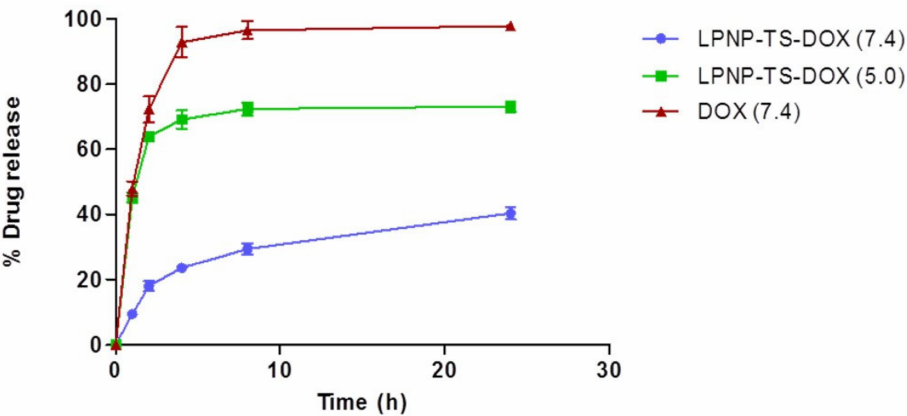
Figure 3. Drug release achieved for free DOX, in PBS buffer (pH 7.4), and encapsulated DOX, in PBS (pH 7.4) and HEPES (pH 5.0) buffers, at 37 ◦ C, by dialysis method. Results are shown by the mean ± standard deviation (n = 3).